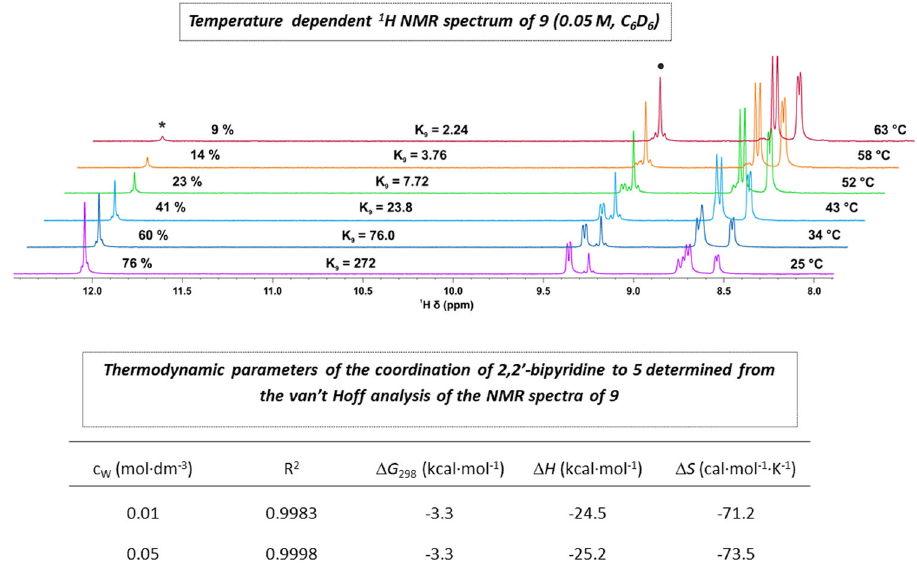
Fig. 8 Temperature dependence of the 1 H NMR spectrum of 9 (0.05 M, C 6 D 6 ) and thermodynamic parameters of the complexation of 5 by 2,2 ′ - bipyridine derived from the van ’ t Hoff analysis of the NMR spectra of 9. Conditions: 0.01 M and 0.05 M solutions of 9 were analyzed by 1 H and 19 F NMR in the 298 K – 323 K temperature range ( fi ve different temperatures) and in the 298 K – 336 K temperature range (six different temperatures), respectively; the corresponding equilibrium constants were determined based on the integrals of the alkylidene and CF 3 signals of 5 and 9 ; the thermodynamic parameters were determined from the R·lnK vs. 10 3 ·T − 1 van ’ t Hoff plots.